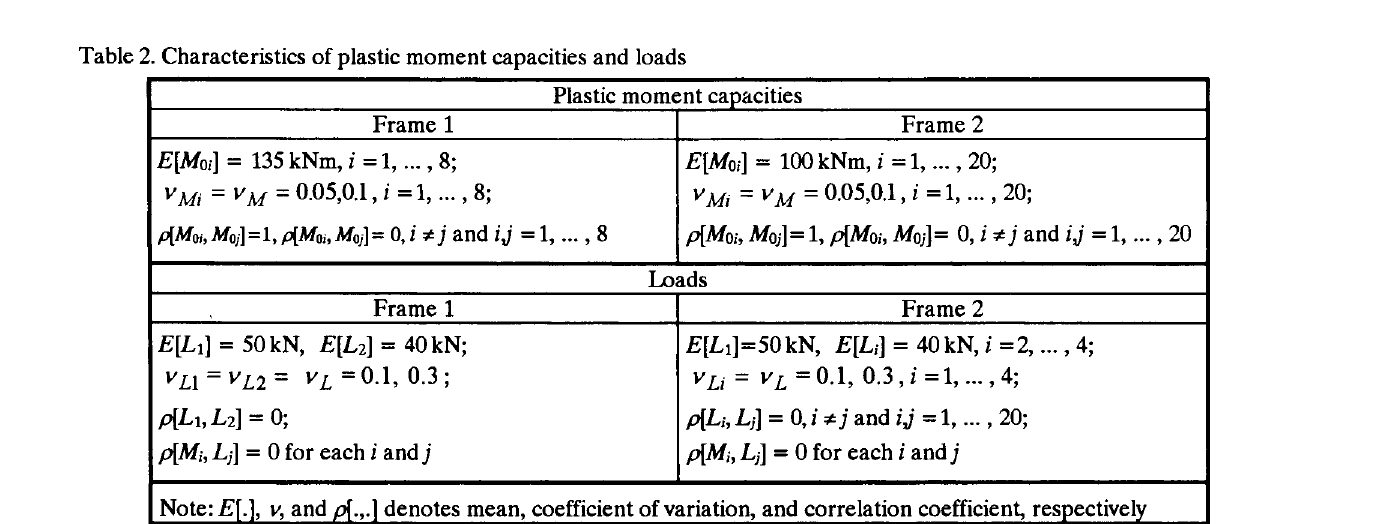
Table 3. &timates of failure probabilities computed with p{ M Oi, M 0 capacities Ratio of C.O.V. of Monte Carlo esti- Radial sampling